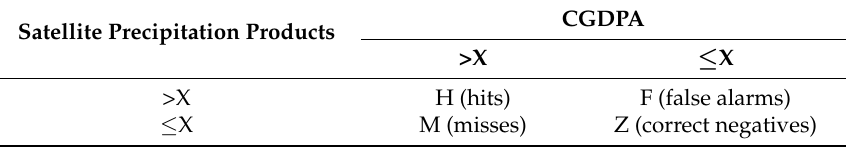
Table 3. Two-by-two contingency table with a threshold of X